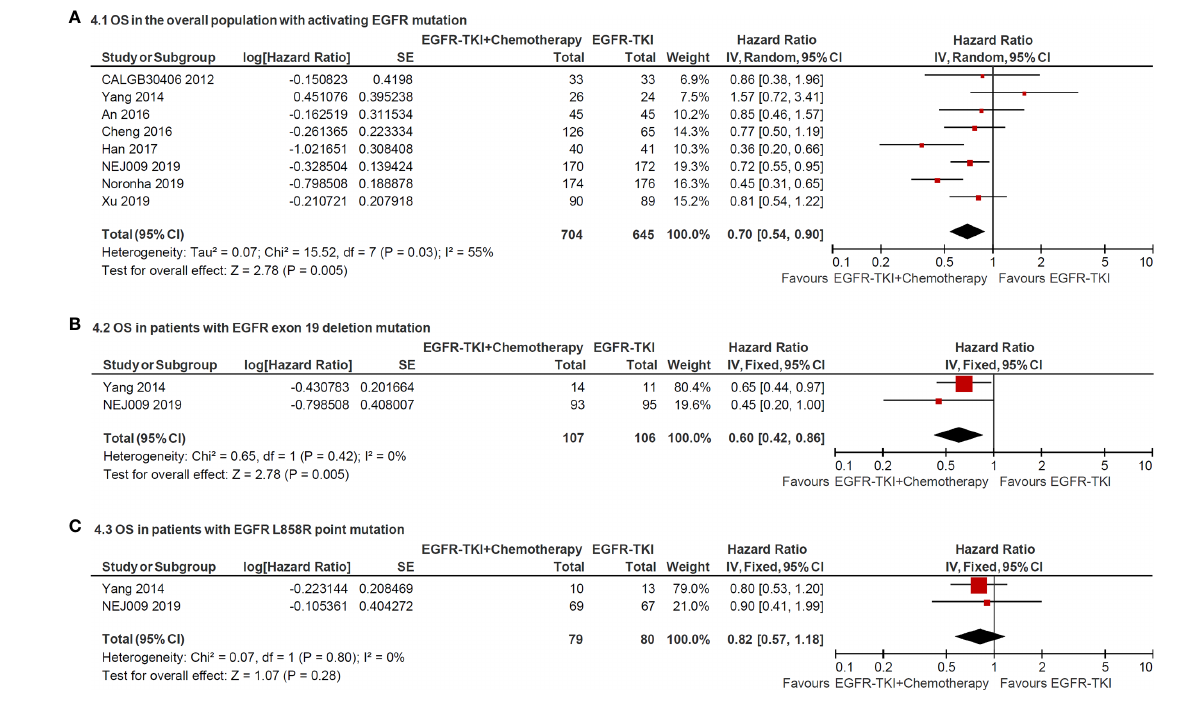
FIGURE 4 | Forest plot of the hazard ratio of overall survival in patients with: (A) all sites of positive activating EGFR mutation; (B) positive exon 19 deletion mutation and (C) positive L858R point